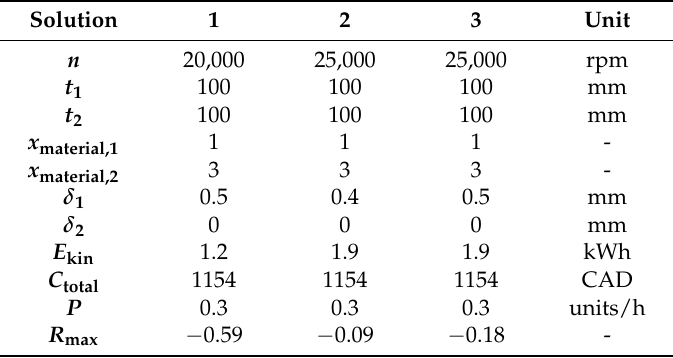
Table 5. Comparison of three solutions and their objective